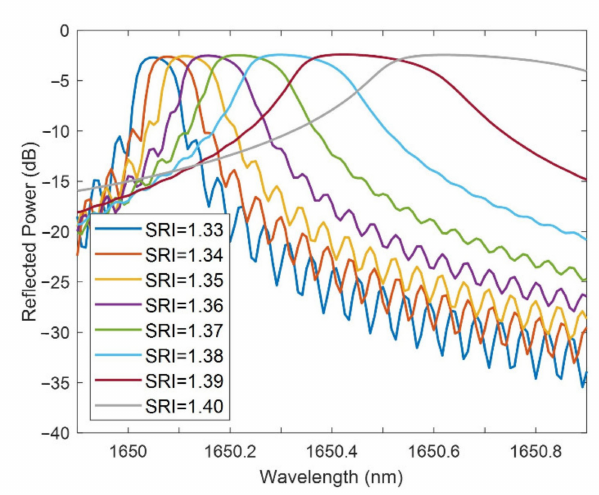
Figure 9. FBG band for different SRI for a thin-film thickness of 125 nm and a neck of 0 µ m. Finally, to end this study, the effect of reducing the thin-film thickness was analyzed. From previous results, diminishing the thickness will lower the power and the FWHM but it is still unknown what will occur with the sensitivity and the